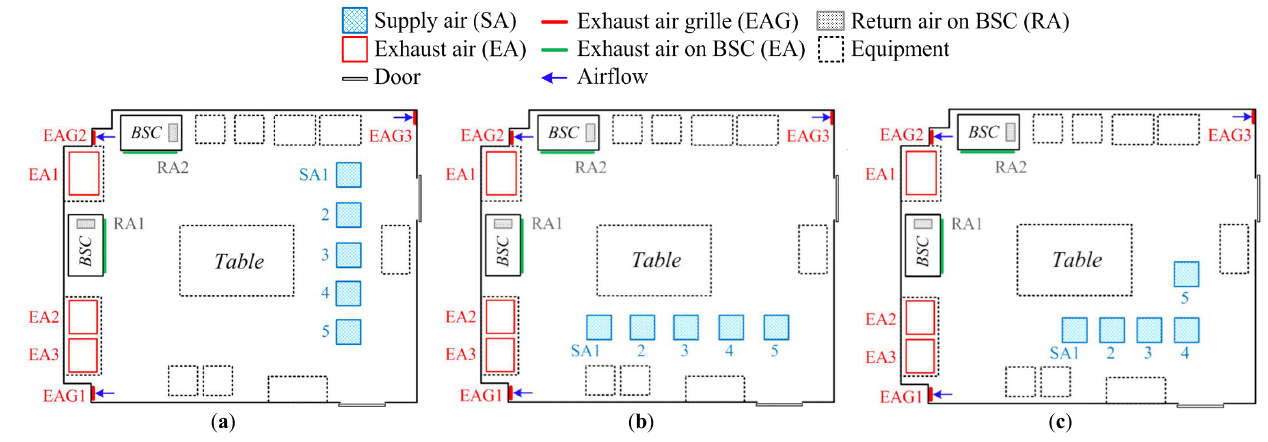
Figure 5. The supply air arrangement at different configurations: ( a ) vertical arrangement; ( b ) hori- zontal arrangement; ( c ) L-shaped arrangement. horizontal arrangement; ( c ) L-shaped